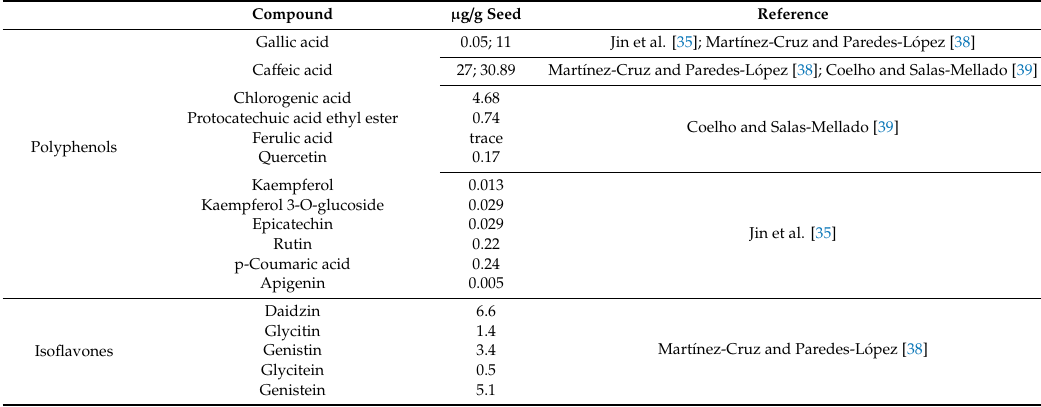
Table 4. Polyphenol and isoflavone contents in chia